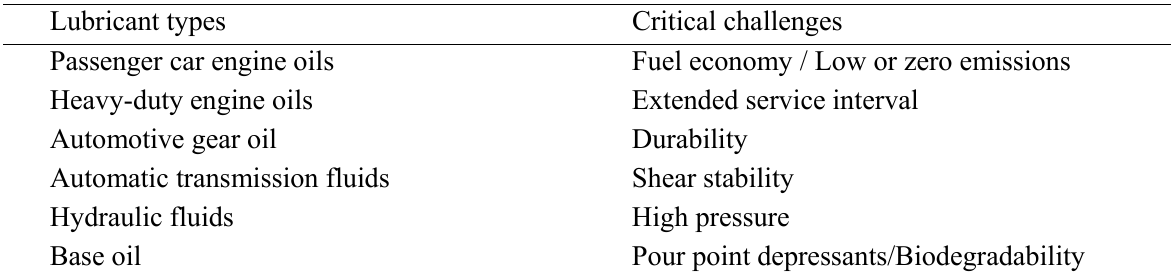
Table 2. Challenges of the future for